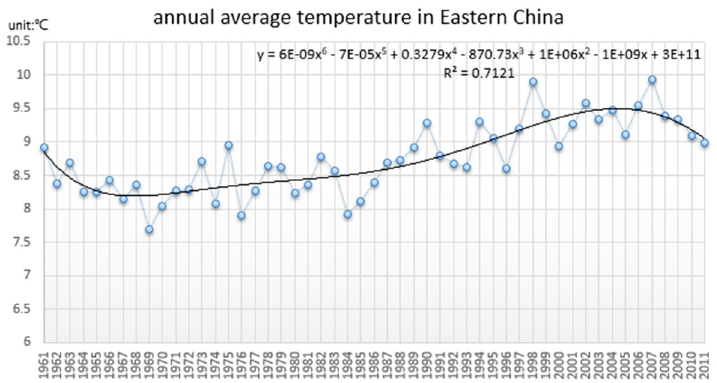
Figure 3. Annual average temperature change in eastern China from 1961 to 2011.